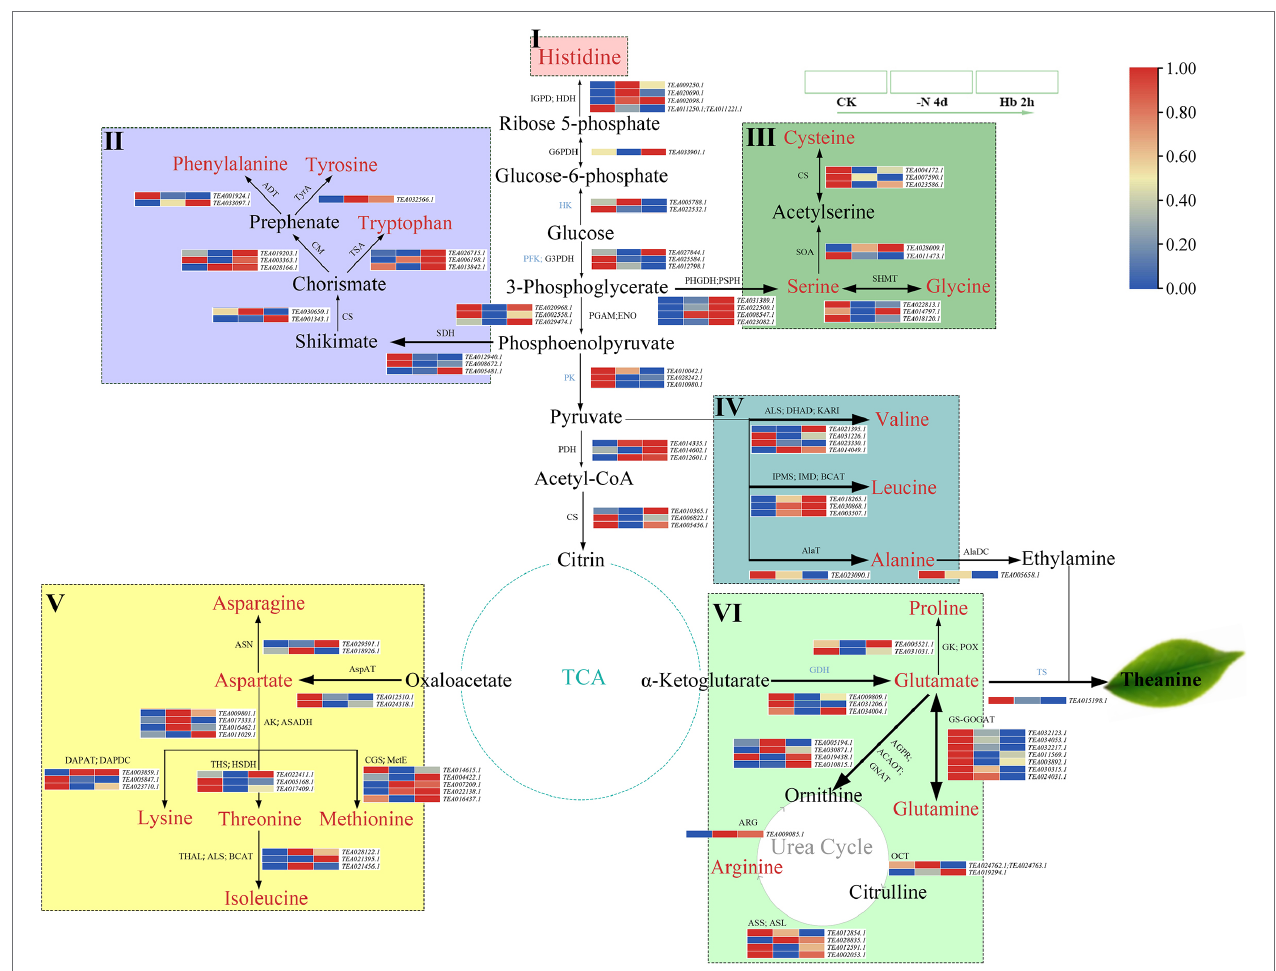
FIGURE 4 | The expression of key genes in the amino acids’ metabolic pathway in C. sinensis roots during N deprivation and resupply. I: histidine family (pink frame); II: aromatic AAs family (purple frame); III: serine family (medium-sea-green frame); IV: alanine family (blue frame); V: aspartate family (yellow frame); VI: glutamate family (light-green frame). Relative expression levels are shown by a color gradient from low (blue) to high (red). IGPD, imidazoleglycerol-phosphate dehydratase; HDH, histidinol dehydrogenase; G6PDH, glucose-6-phosphate dehydrogenase; HK, hexokinase; PFK, phosphohexokinase; G3PDH, glyceraldehyde- 3-phosphate dehydrogenase; PGAM, phosphoglycerate mutase; ENO, enolase; PK, pyruvate kinase; PDH, pyruvate dehydrogenase; CS, citrate synthase; SDH, shikimate dehydrogenase; CS, chorismate synthase; TSA, tryptophan synthase; CM, chorismate mutase; ADT, arogenate dehydratase; TyrA, arogenate dehydrogenase; PSPH, phosphoserine phosphatase; PHGDH, phosphoglycerate dehydrogenase; SOA, serine O-acetyltransferase; ALS, acetolactate synthase; DHAD, dihydroxy-acid dehydratase; KARI, ketol-acid reductoisomerase; IPMS, 3-isopropylmalate/(R)-2-methylmalate dehydratase small subunit; IMD, isopropylmalate dehydrogenase; BCAT, branched-chain-amino-acid transaminase; AlaT, alanine transaminase; AspAT, aspartate aminotransferase; ASN, asparagine synthase; DAPAT, diaminopimelate aminotransferase; DAPDC, diaminopimelate decarboxylase; THS, threonine synthase; HSDH, homoserine dehydrogenase; THAL, threonine dehydratase; CGS, cystathionine gamma-synthase; MetE, 5-methyltetrahydropteroyltriglutamate-homocysteine methyltransferase; GDH, glutamate dehydrogenase; GK, glutamate 5-kinase; POX, proline oxidase; AGPR, N-acetyl-gamma-glutamyl-phosphate reductase; ACAOT, acetylornithine